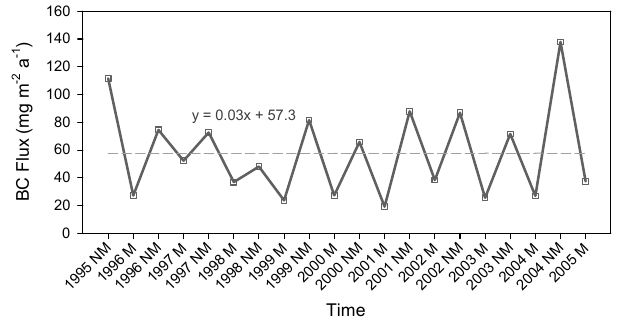
Figure 5. Seasonal dependence (“NM” for non-monsoon season and “M” for monsoon season) of BC deposition flux at the Zuo- qiupu site from 1995 to 2005 simulated in CAM5. The dashed line represents a linear regression of all data